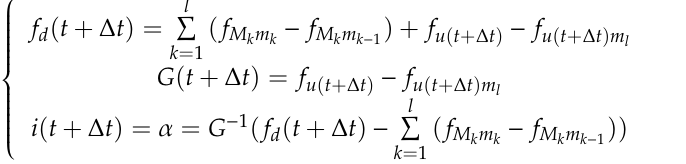
Figure 6. Performance of the Preisach model at